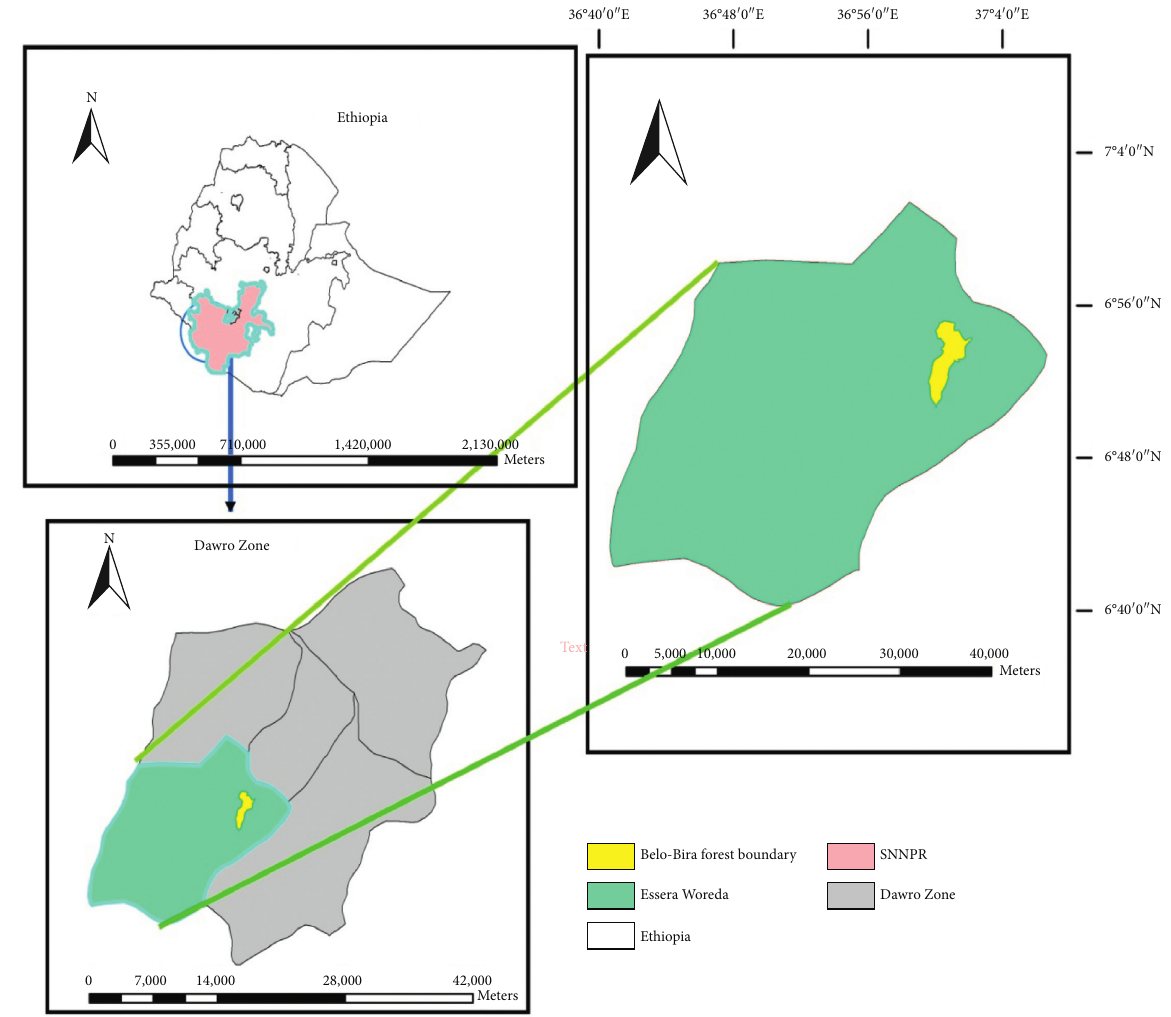
Figure 1: Locations of Belo-Bira Table 1: Demographic characteristics of sampled population.